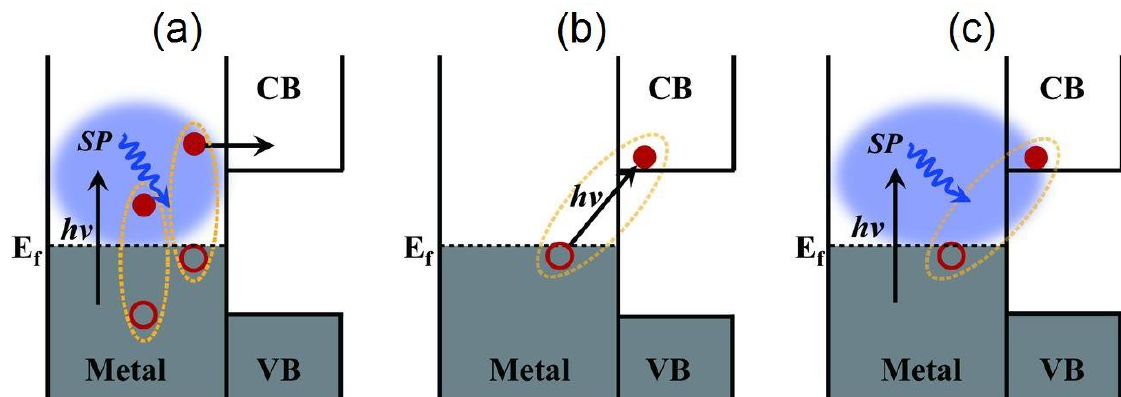
Figure 6. A perspective on the various charge-separation pathways in noble metal–semiconductor systems. ( a ) The conventional plasmonic hot electron transfer (PHET) mechanism where a plasmon (blue ellipsoidal cloud) in the noble metal dephases into a hot electron-hole pair via Landau damping, following which, the hot electron is injected into the conduction band (CB) of the semiconductor. The electron-hole pairs generated in such a manner display a broad distribution of energies. ( b ) The IFCT mechanism where an electron in the noble metal is directly excited into the CB of the semiconductor, and its plasmonic counterpart in ( c ) PICTT where the plasmon dephases with the direct creation of an electron in the CB of the semiconductor and a hole in the metal. VB indicates the semiconductor valence band, while hν is the energy of the incident photon. Reprinted with permission from Ref [134] Copyright The American Association for the Advancement of Science (2015).